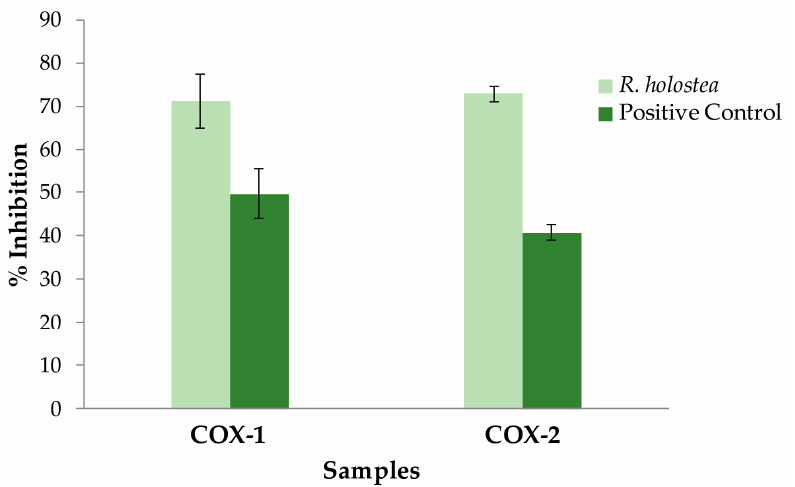
Figure 4. The inhibition of R. holostea methanolic extract (50 µg/mL) towards COX-1 and COX-2 activities. The results are from two independent experiments (n = 4, mean ± SD). Positive controls: Indomethacin (1.25 µM) for COX-1 and NS-398 (5 µM) for COX-2, according to Katani ć et al. [14].